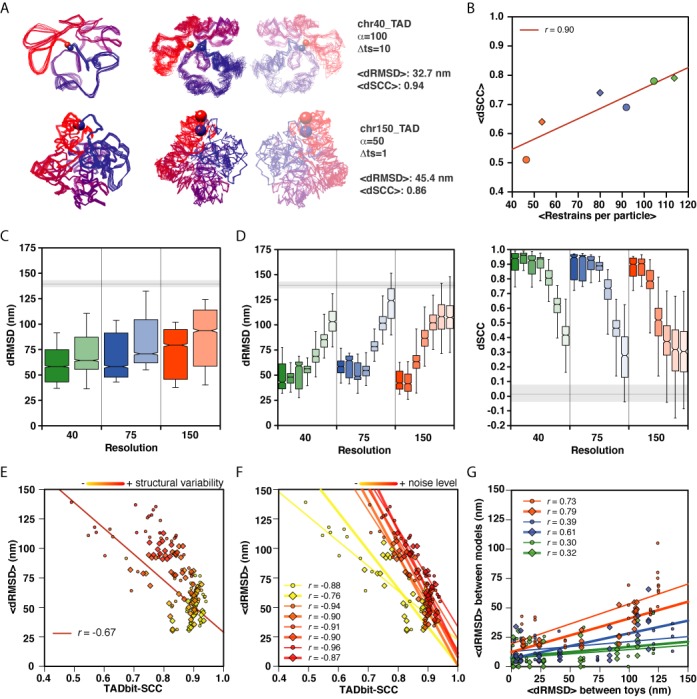
Model assessment. (A) Comparison of a 3D model ensemble of genome architectures for the chr40_TAD (top) and chr150_TAD (bottom) architectures. Superimposed input structures for set 0 (left models) and superimposed reconstructed 3D models (due to mirroring, TADbit generates right- and left-handed models (9)). Models are colored from particle 1 in blue to particle N in red, the start and end particles are highlighted with spheres. (B) Correlation between the restraints per particle and the accuracy of the reconstructed models as measured by the average dSCC score per architecture. Circle symbols correspond to non-TAD-like architectures. Rhomboid symbols correspond to TAD-like architecture. The colors indicate the toy genome density (green, blue and orange for 40, 75 and 150 bp/nm, respectively). (C) dRMSD distributions with respect to genome architecture. Colors correspond to the three density values with dark and pale colors corresponding to TAD-like and non-TAD-like architectures, respectively. Horizontal gray line and shade corresponds to the dRMSD distributing of comparing a ‘random genome’ of the same size and number of particles as the reconstructed models but with randomized coordinates. (D) Model accuracy as measured by dRMSD (left) and dSCC (right) with respect to the model density. Each density is colored as in panel A and contains seven distributions from the seven sets of structures from set 0 (\documentclass[12pt]{minimal}
\usepackage{amsmath}
\usepackage{wasysym}
\usepackage{amsfonts}
\usepackage{amssymb}
\usepackage{amsbsy}
\usepackage{upgreek}
\usepackage{mathrsfs}
\setlength{\oddsidemargin}{-69pt}
\begin{document}
}{}$\Delta t = 1$\end{document}) to high structural variability set 6 (\documentclass[12pt]{minimal}
\usepackage{amsmath}
\usepackage{wasysym}
\usepackage{amsfonts}
\usepackage{amssymb}
\usepackage{amsbsy}
\usepackage{upgreek}
\usepackage{mathrsfs}
\setlength{\oddsidemargin}{-69pt}
\begin{document}
}{}$\Delta t = 10^6$\end{document}) with dark to pale colors, respectively. Horizontal gray lines and shade as in panel C. (E) Correlation between the dRMSD values per reconstructed models and the Spearman correlation coefficient of the contact map from the reconstructed models and the original toy genome structures (TADbit- SCC). The points are colored proportional to the level of structural variability in the matrix (yellow to red from low set 0 (\documentclass[12pt]{minimal}
\usepackage{amsmath}
\usepackage{wasysym}
\usepackage{amsfonts}
\usepackage{amssymb}
\usepackage{amsbsy}
\usepackage{upgreek}
\usepackage{mathrsfs}
\setlength{\oddsidemargin}{-69pt}
\begin{document}
}{}$\Delta t = 1$\end{document}) to high structural variability set 6 (\documentclass[12pt]{minimal}
\usepackage{amsmath}
\usepackage{wasysym}
\usepackage{amsfonts}
\usepackage{amssymb}
\usepackage{amsbsy}
\usepackage{upgreek}
\usepackage{mathrsfs}
\setlength{\oddsidemargin}{-69pt}
\begin{document}
}{}$\Delta t = 10^6$\end{document})). Shapes represented as in panel B. (F) Same as panel E but now the points are colored by the level of noise in the data (yellow to red for low to high levels of noise, that is from α = 50 to 200). The regression coefficients indicate the correlation per noise level α. (G) Correlation between structural variability in the toy genome structures and in the reconstructed models. Colors and shapes as in panel B.